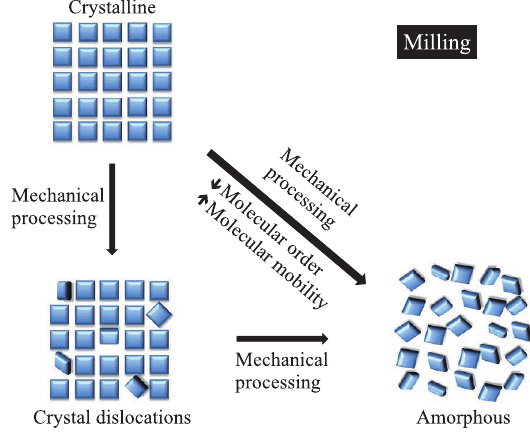
Fig. 3 Mechanical activation of crystalline powders. A portion of the mechanical energy supplied during milling is stored in the material in the form of crystal defects and/or amorphous